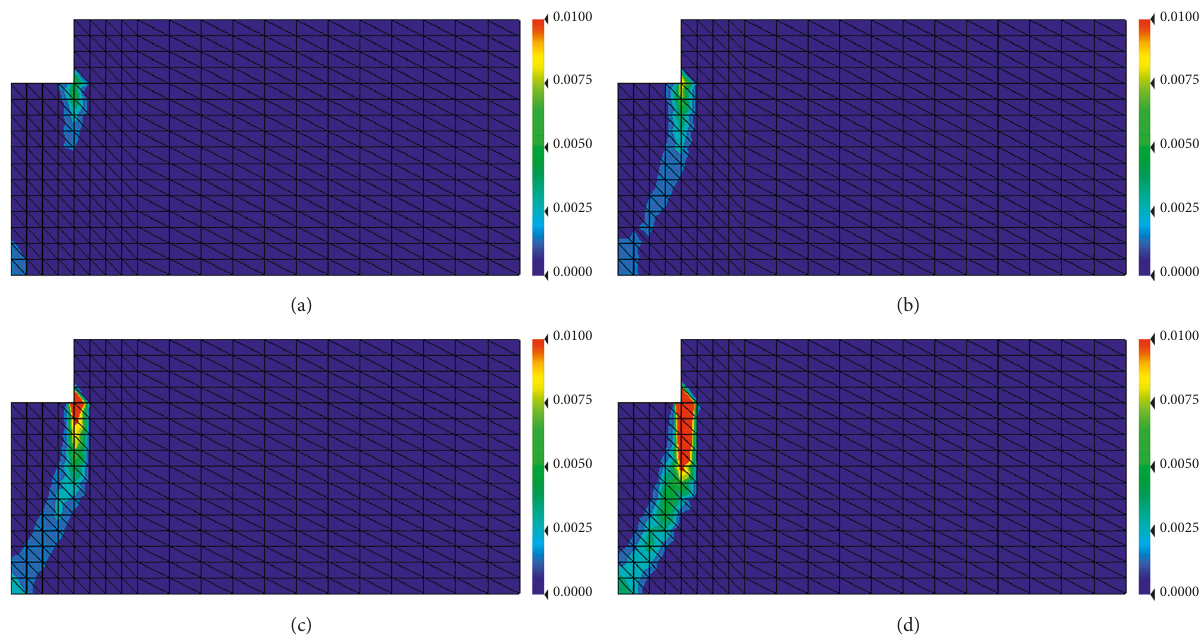
Figure 10: Comparing the slip bands for various dilatancy angles while locking the maximum plastic strain: (a) θ θ 10 ° ; (d) θ 0 ° (cid:31) (cid:31)